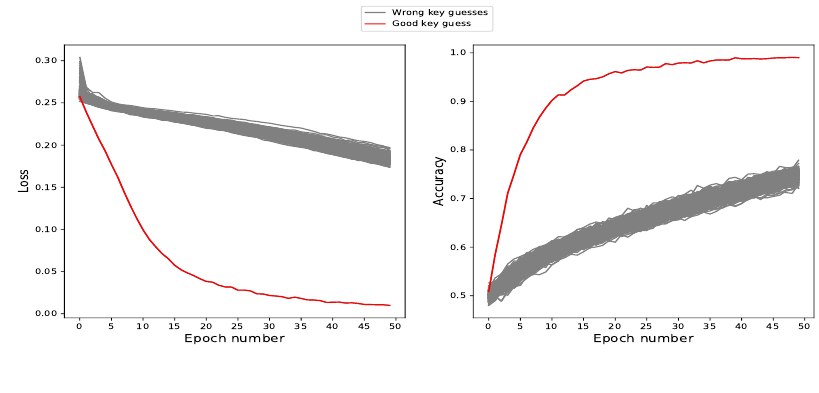
Figure 6: Loss (left) and accuracy (right) over the training epochs for all the key guesses when applying